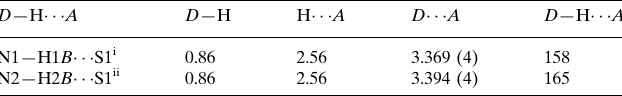
Hydrogen-bond geometry (A˚ , (cid:2)